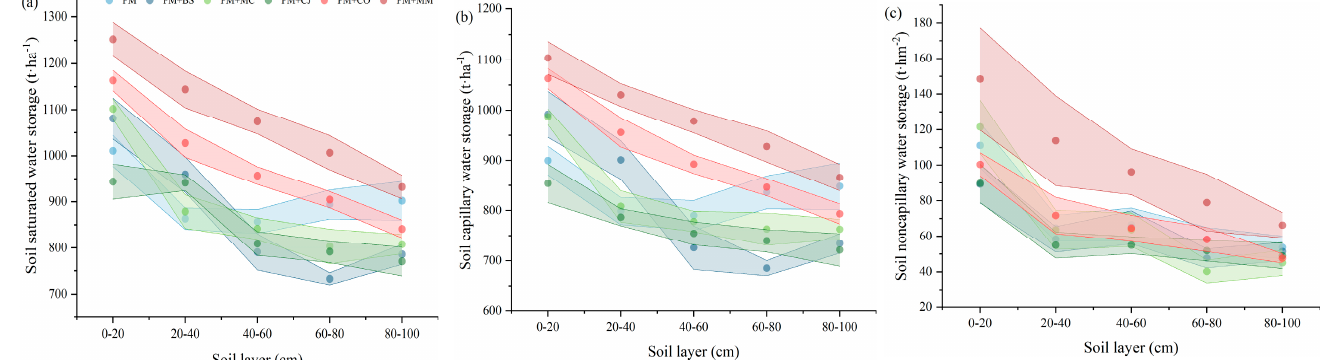
Figure 2. (a) Soil–saturated water storage , (b) capillary water storage, and (c) noncapillary water storage in different forest types. Note: the points denote the overall mean values, and the shaded regions represent the 95% CIs. Pinus massoniana (PM), Bretschneidera sinensis (BS), Manglietia chingii (MC), Cercidiphyllum japonicum (CJ), Camellia oleifera (CO), and Michelia maudiae (MM).